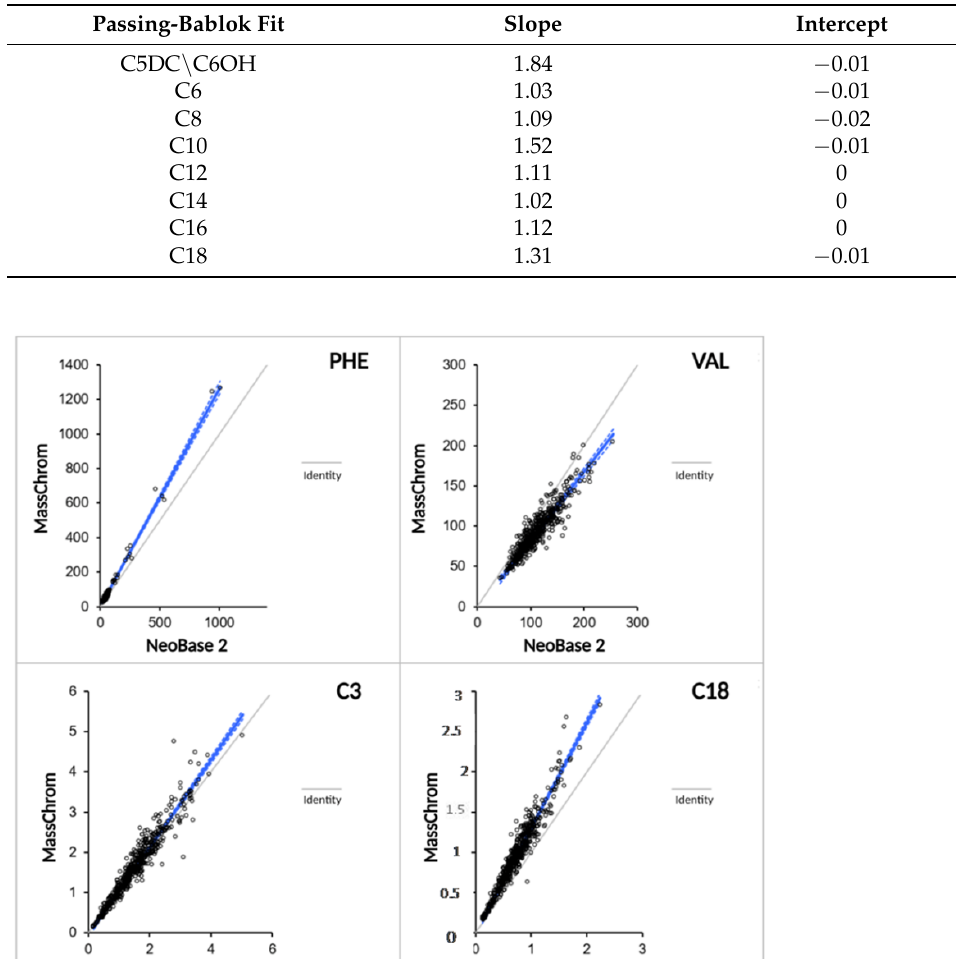
Figure 4. ( a ) Residual plots for Phe, Val, C3, and C18 after method comparison between NeoBase™ 2 and MassChrom ® non-derivatized kits; ( b ) difference plots for Leu, Phe, and Val after the removal of DBS samples from diagnosed IEMs subjects.